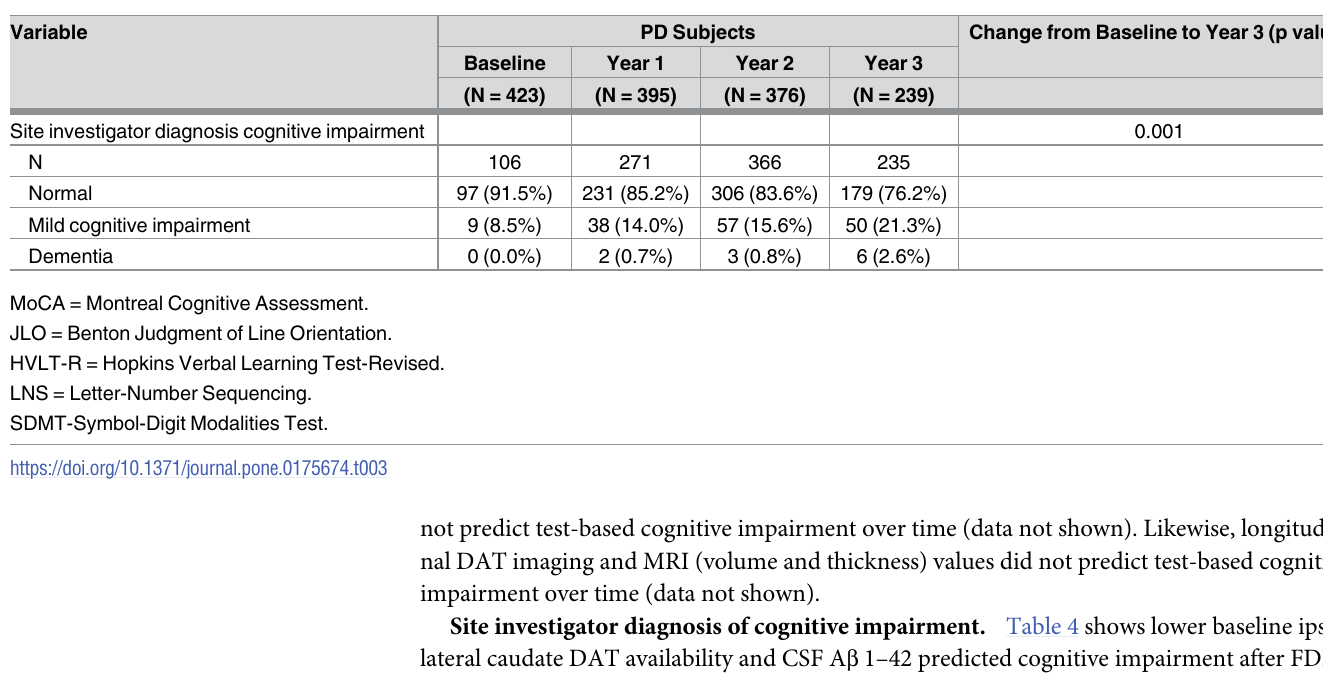
Table 4. Baseline biomarker predictors of investigator diagnosis of cognitive impairment.